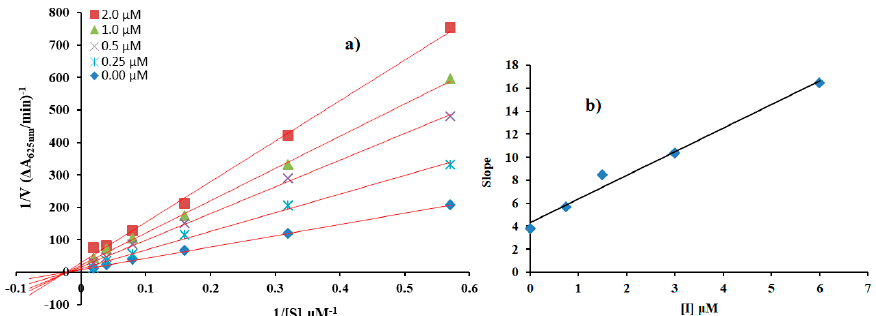
Figure 2. Kinetic analysis results for target molecule 4a . ( a ) Lineweaver-Burk plots for the inhibition of urease in the presence of compound 4a . Concentrations of 4a of 0, 0.75, 1.5, 3, and 6 µM, respectively. Substrate urea concentrations were 1.57, 3.12, 6.25, 12.5, 25, and 50 µM, used respectively; ( b ) The secondary replot of the Lineweaver-Burk plot, slope vs. various concentrations of 4a .